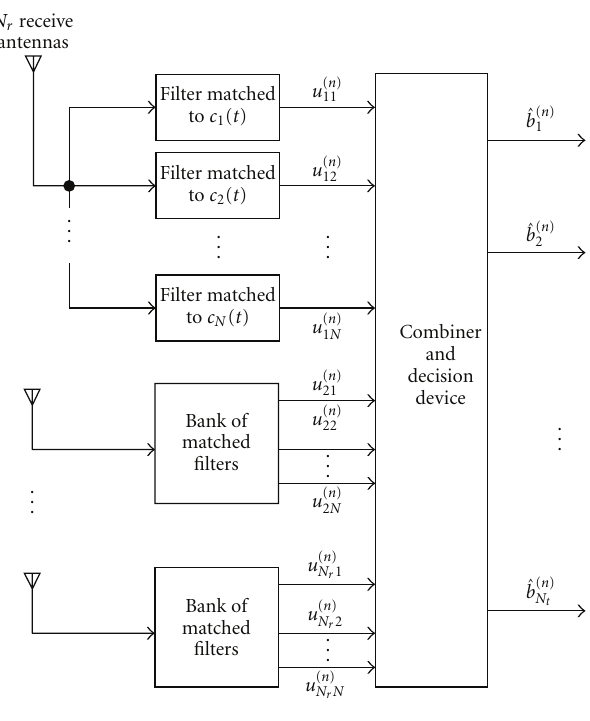
Figure 2: MIMO-CDMA receiver.